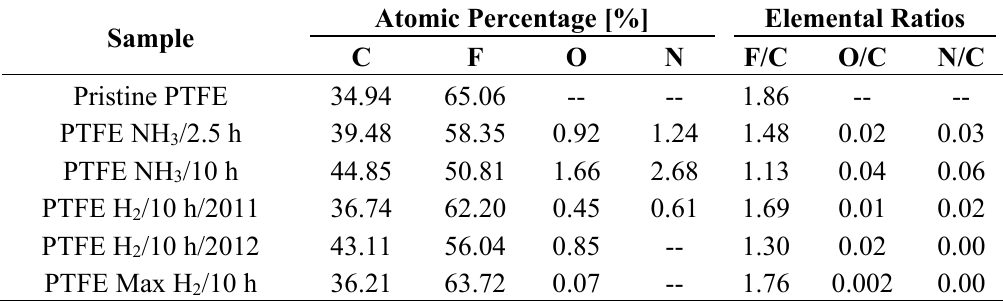
Table 1. Atomic percentages and associated elemental ratios of PTFE